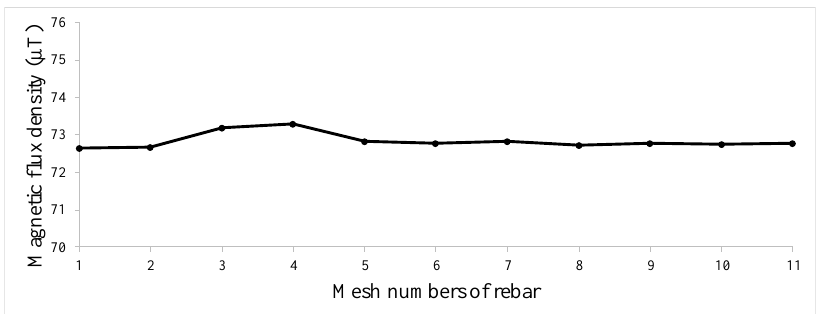
Figure 8. Minimum values of Z-component magnetic flux density, from 295.0592 mm to 307.0592 mm (values related to Hole 2), for different mesh specifications of rebar with fixed box mesh #1.